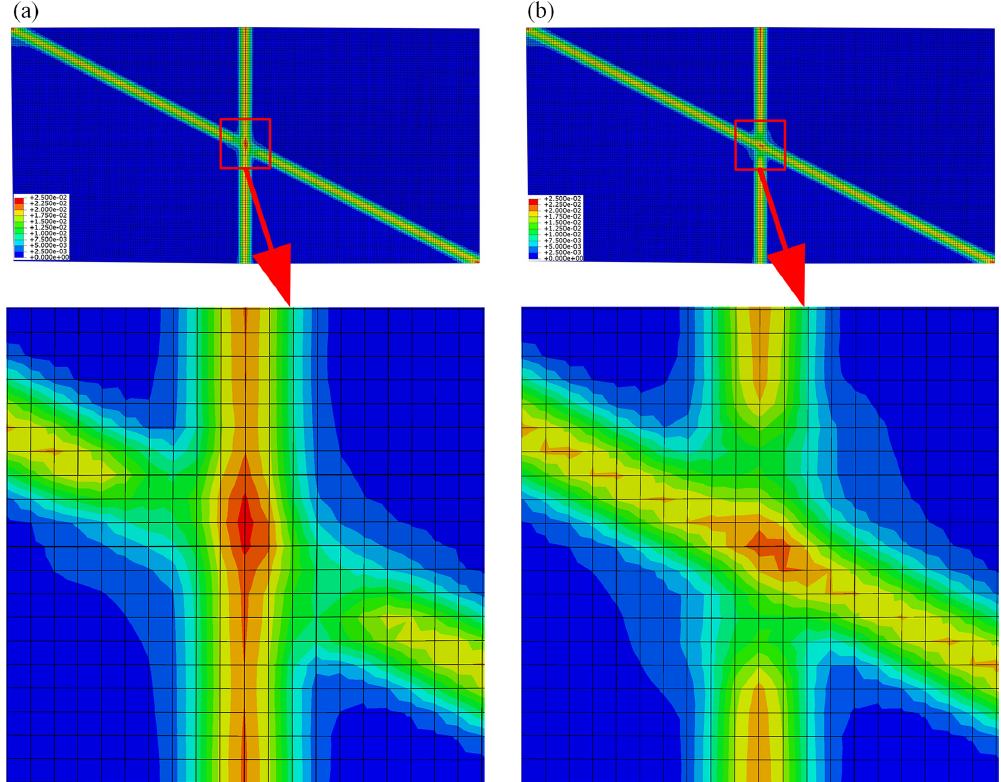
Figure 11. Maximum principal strain distribution of different loading sequences. (a) Loading scheme 1. (b) Loading scheme 2.